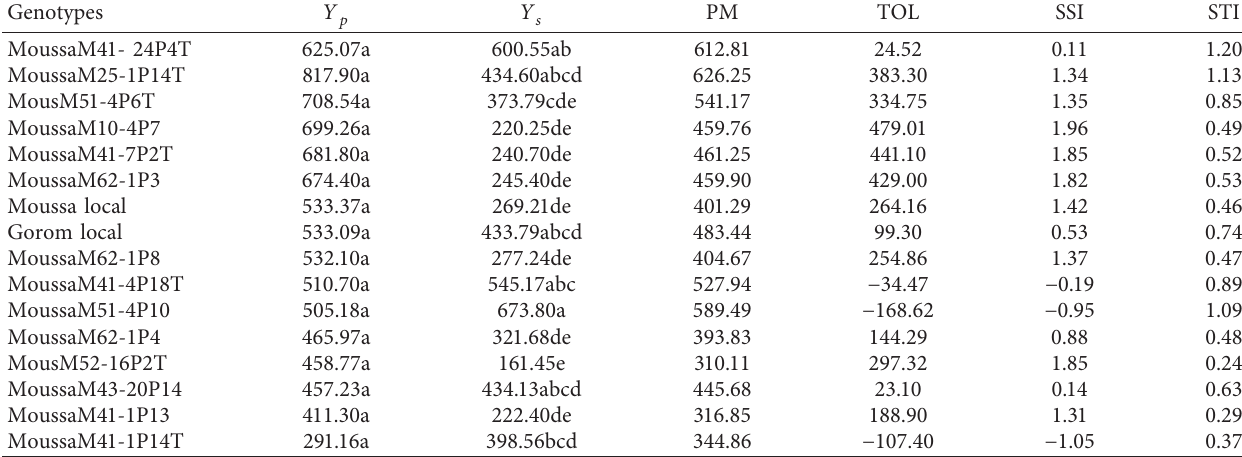
Table 3: Estimates of drought tolerance indices of cowpea mutant under normal and stressed conditions. Genotypes